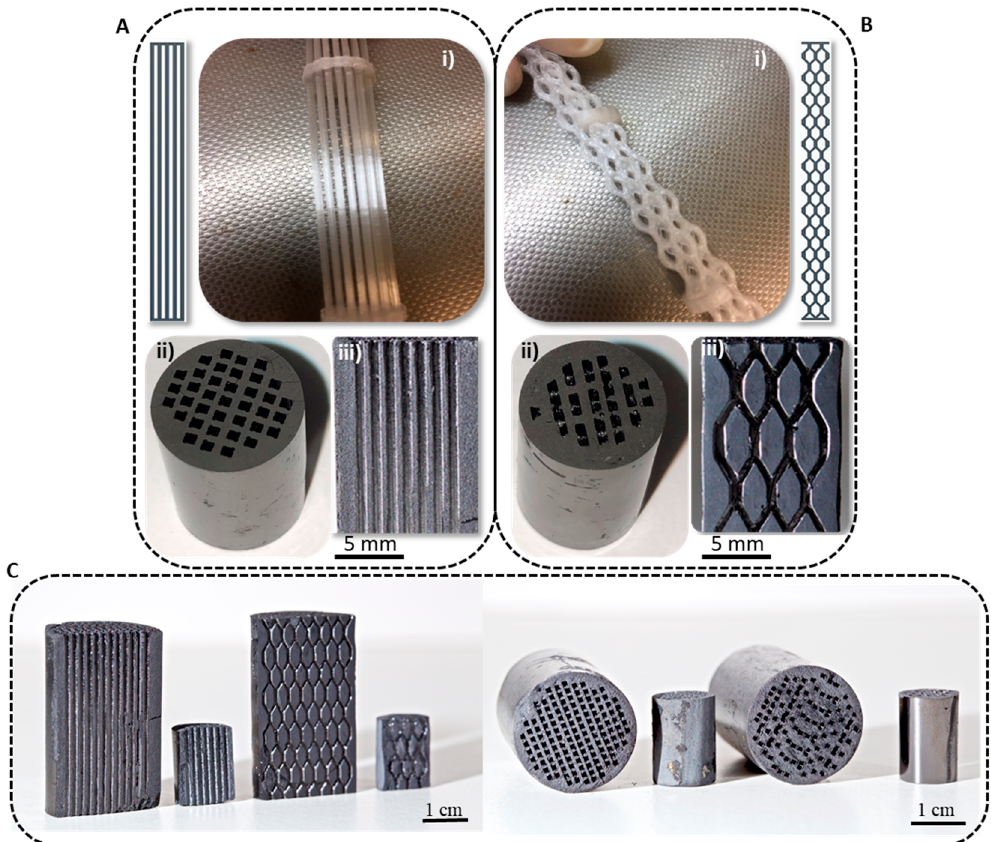
Figure 2. Integral carbon monoliths obtained by 3D printing with two different channels configurations (R/W = 1/17): Straight ( A ) and tortuous ( B ) channels. ( i ) 3D-printed template. ( ii ) Top view of the monoliths. ( iii ) Cross section of the monoliths. ( C ) Size scalability of carbon monoliths prepared using 3D printing.